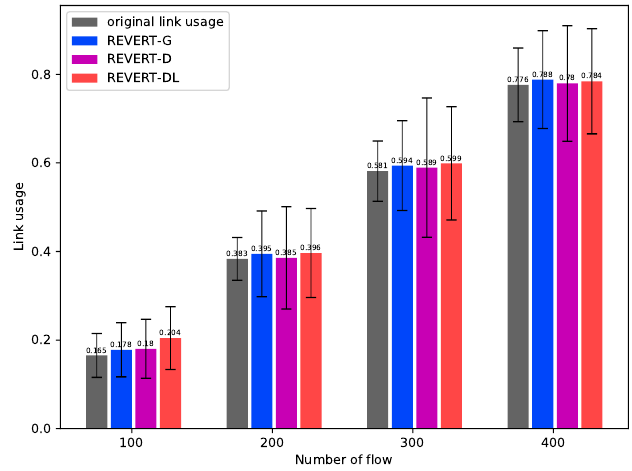
Figure 8. Comparison of link